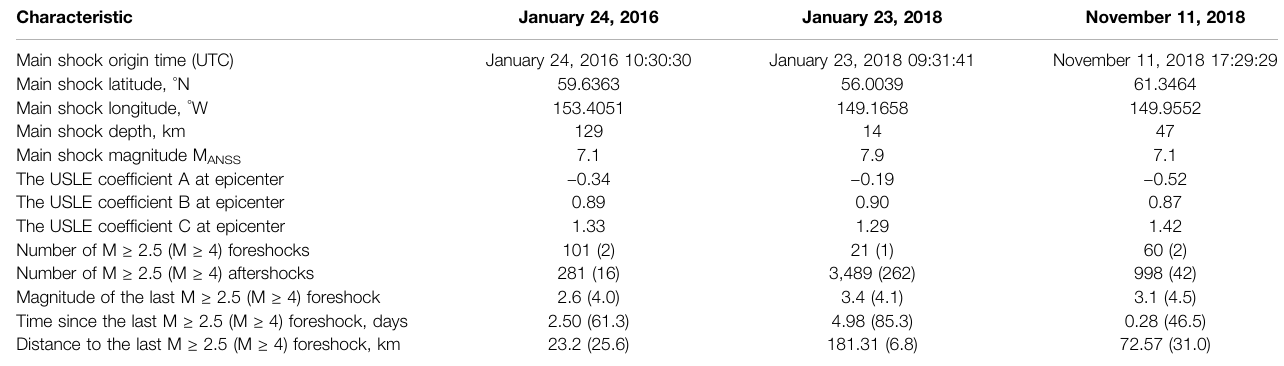
TABLE 1 | Characteristics of the three major earthquake series in Southern Alaska, 2016 – 2018. Coef fi cients of the Uni fi ed Scaling Law for Earthquakes (USLE) are from the global map determinations (Nekrasova and Kossobokov, 2002) available from the ISC Dataset Repository.